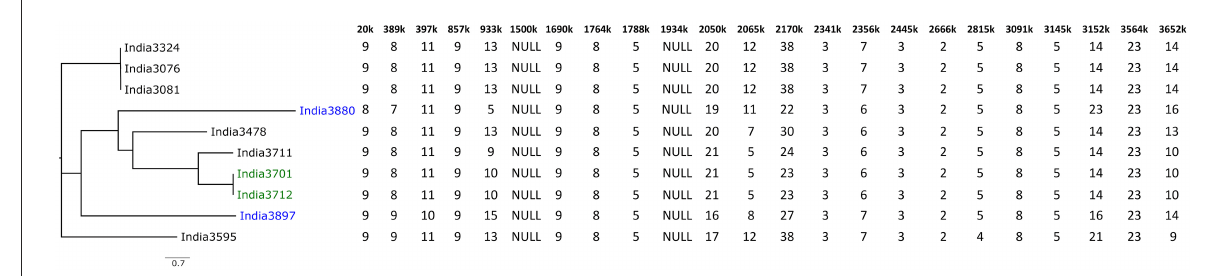
FIGURE4 Example of MLVA-23 analysis of ten B. mallei strains from India (42). The allele number of each loci is given in the table. The Neighbor Joining tree was created using GrapeTree (44). Isolates colored in blue and green belong to HMR-PCR-based SNP group L2B2sB2_India-Group_1 and L2B2sB2_India-Group_2, respectively (45).